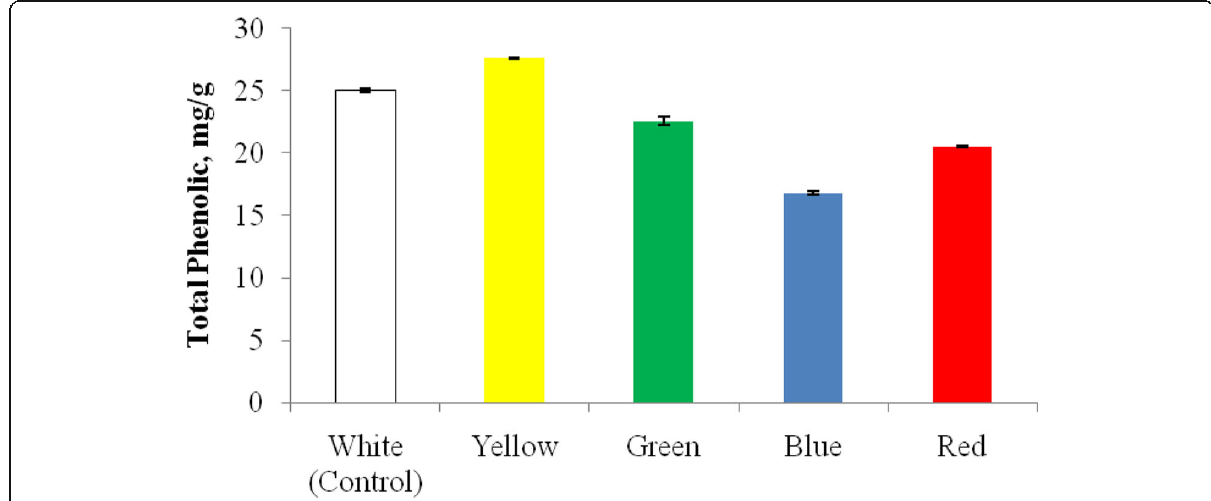
Fig. 2 Total phenolic contents (mg/g DW) under different lights qualities represent means ± slandered errors from triplicates